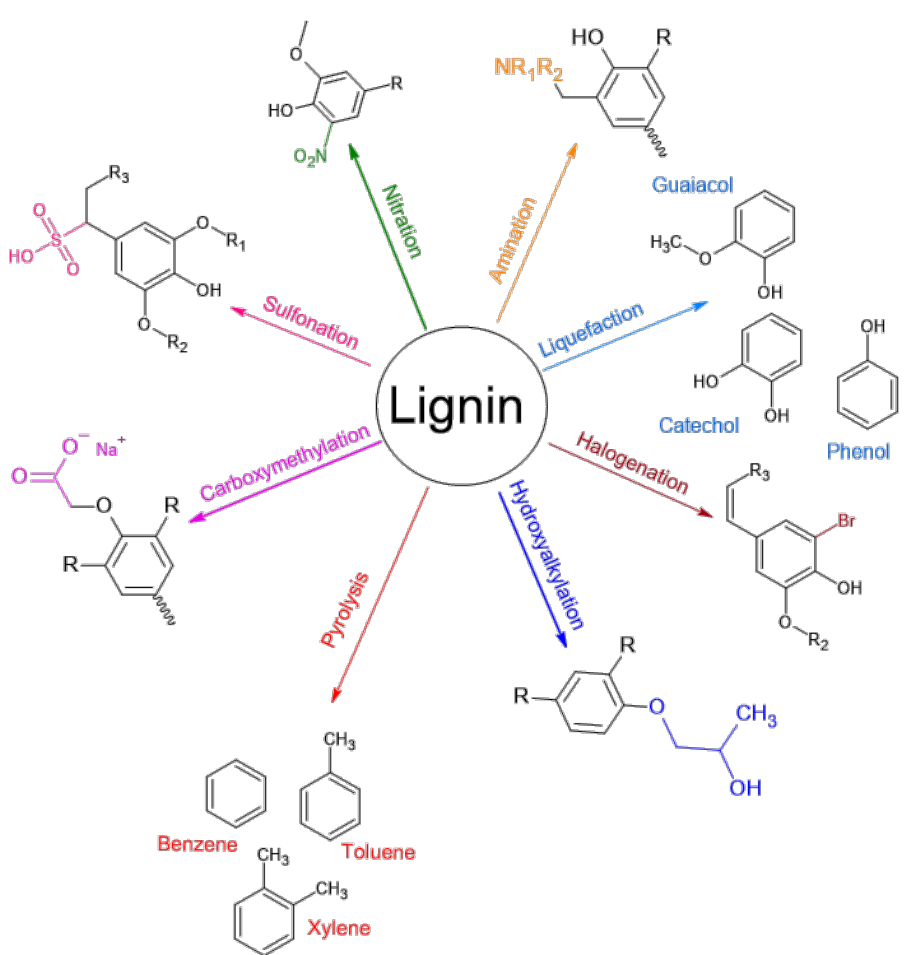
Figure 3. Different pathways of depolymerization and modifications of lignin and its final